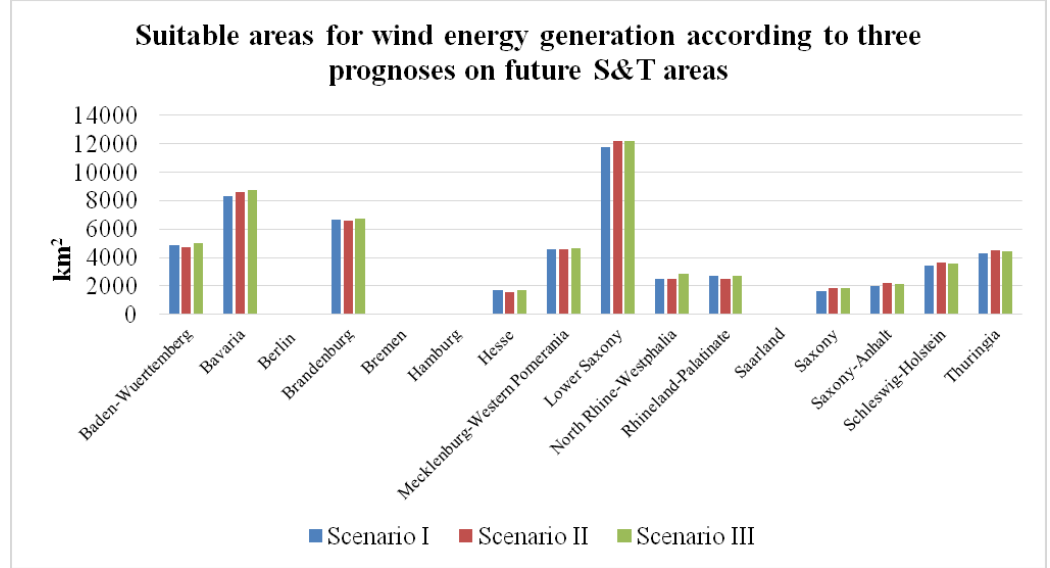
Figure 7. Suitable areas for wind energy conversion according to three prognoses on future S&T areas.